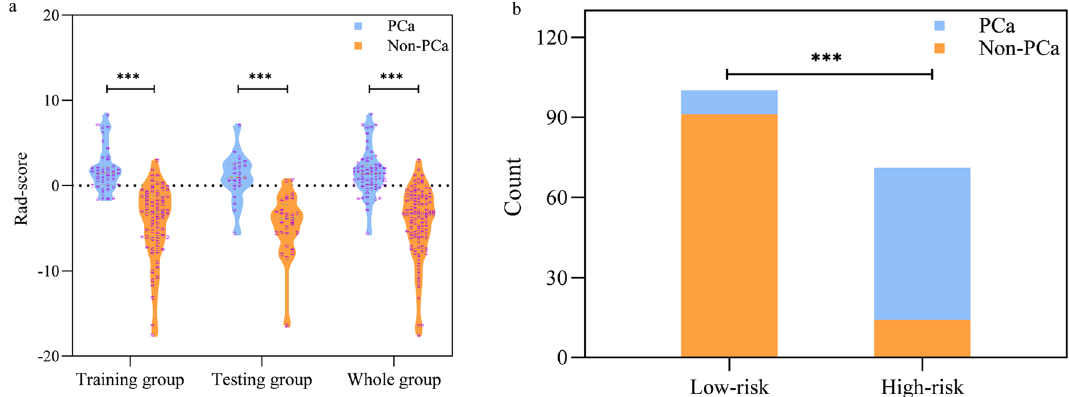
Figure 2. The rad-score violin plots of radiomics model ( a ). The probability of prostate cancer in the high-risk set was significantly higher than that in the low-risk set according to the radiomics model ( b ). PCa prostate cancer, Non-PCa non-prostate cancer; *** represents P < 0.001.